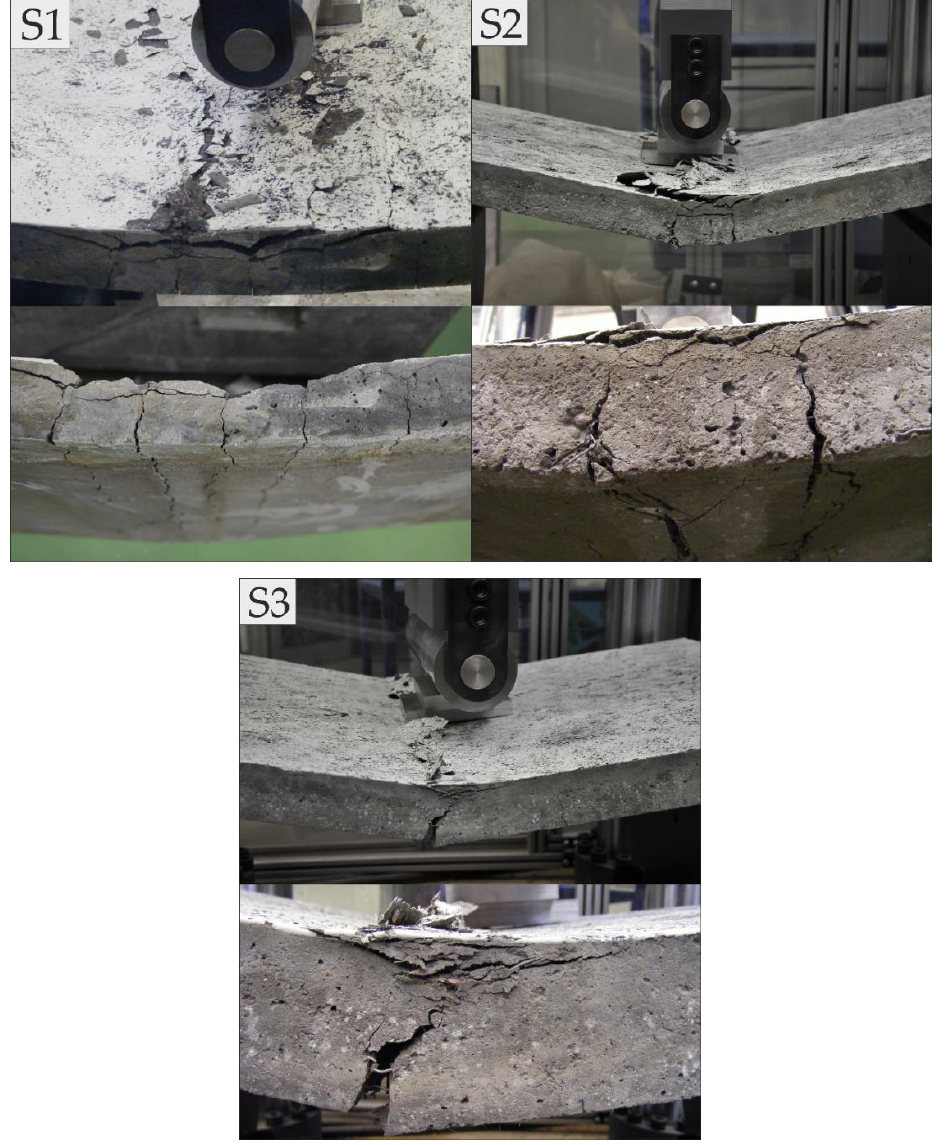
Figure 10. Failure Figure 10. Failure modes.